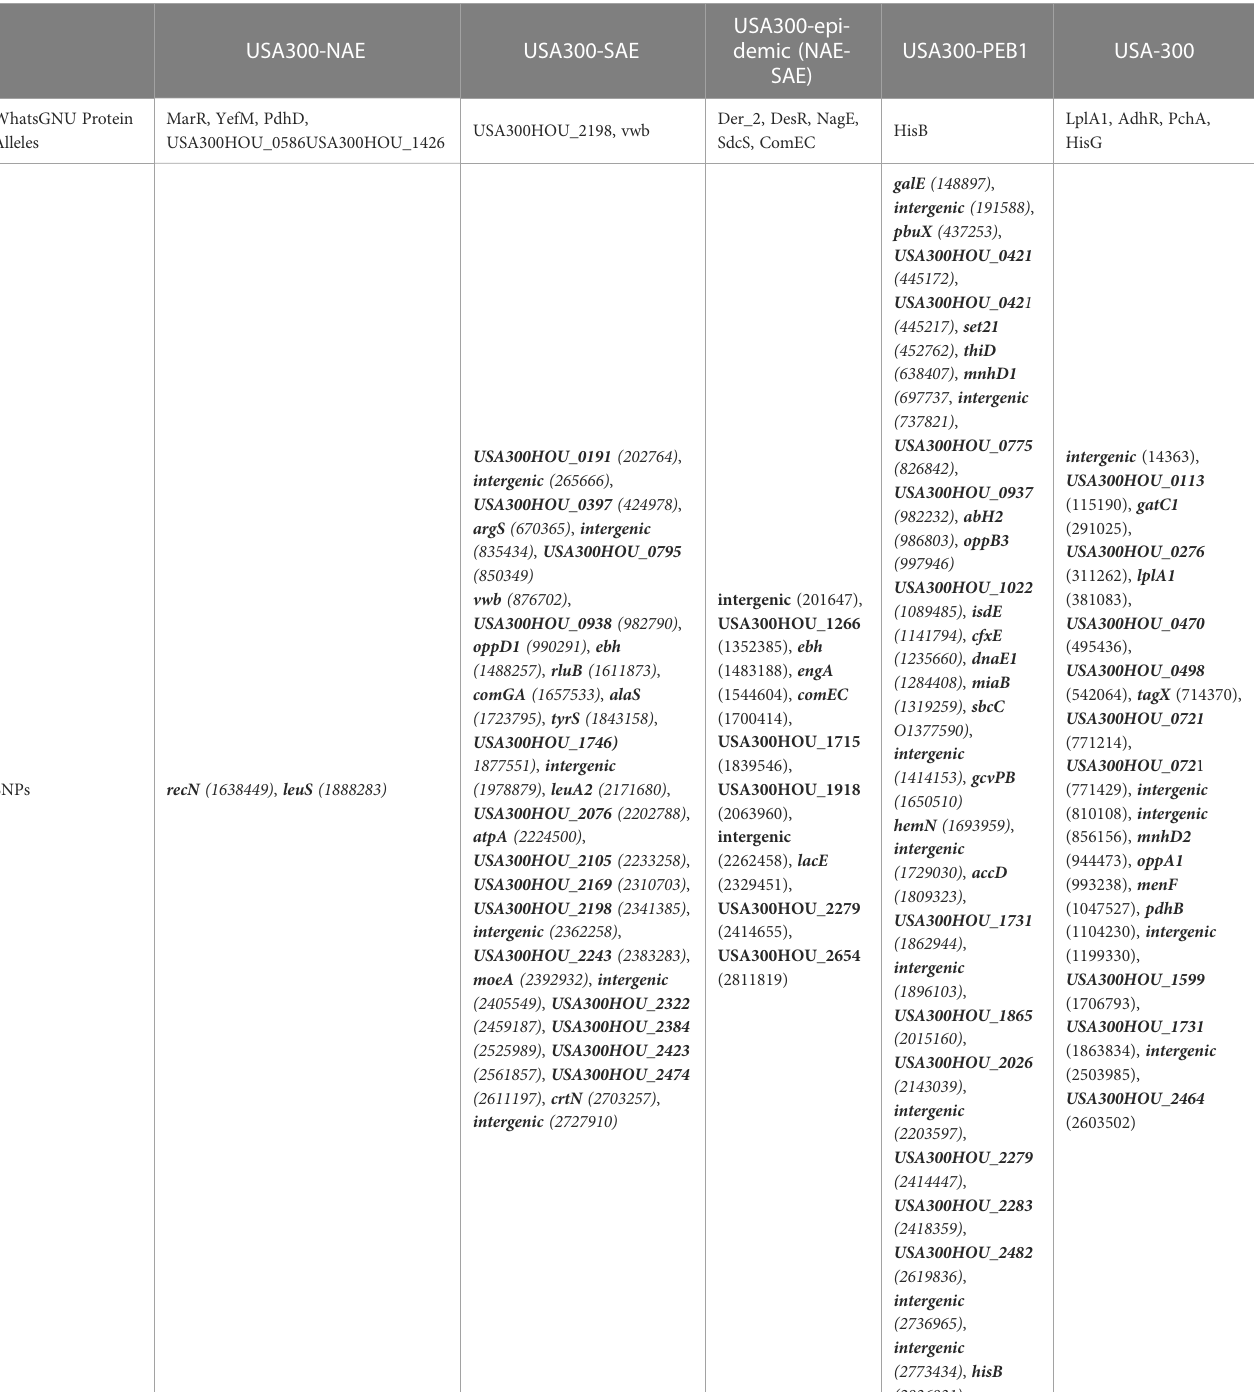
TABLE 1 Unique SNPs and protein alleles of USA-300 strains for identi fi cation